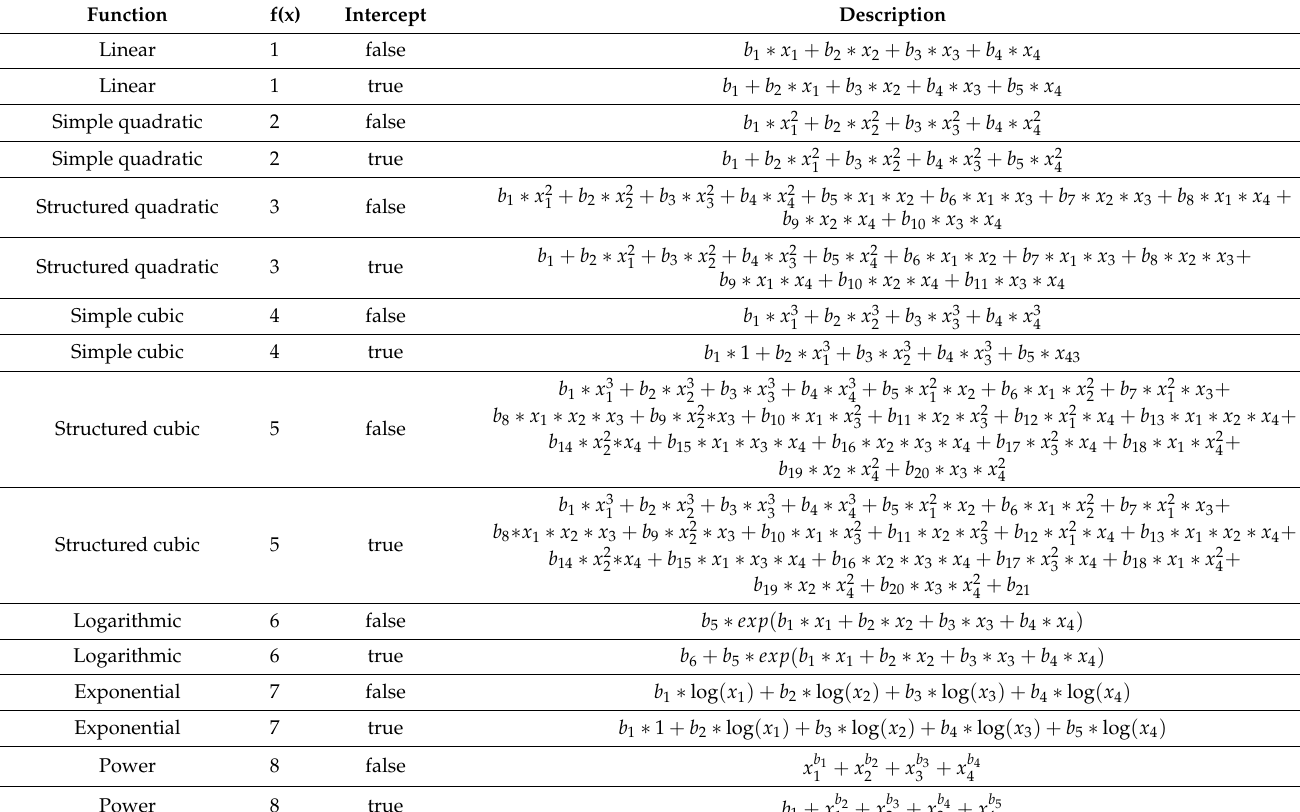
Table A1. List of functions used to determine the simulated ejector